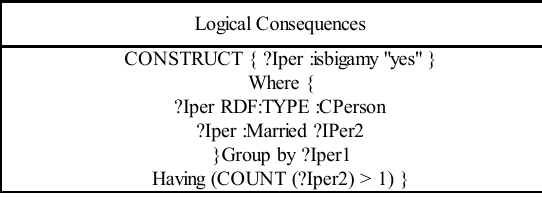
TABLE 5. CONSEQUENCE